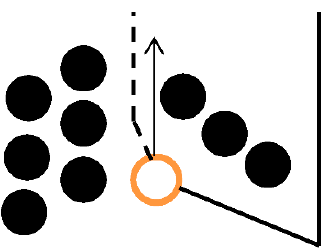
Figure 2. Unnecessary path developed by the social force model.